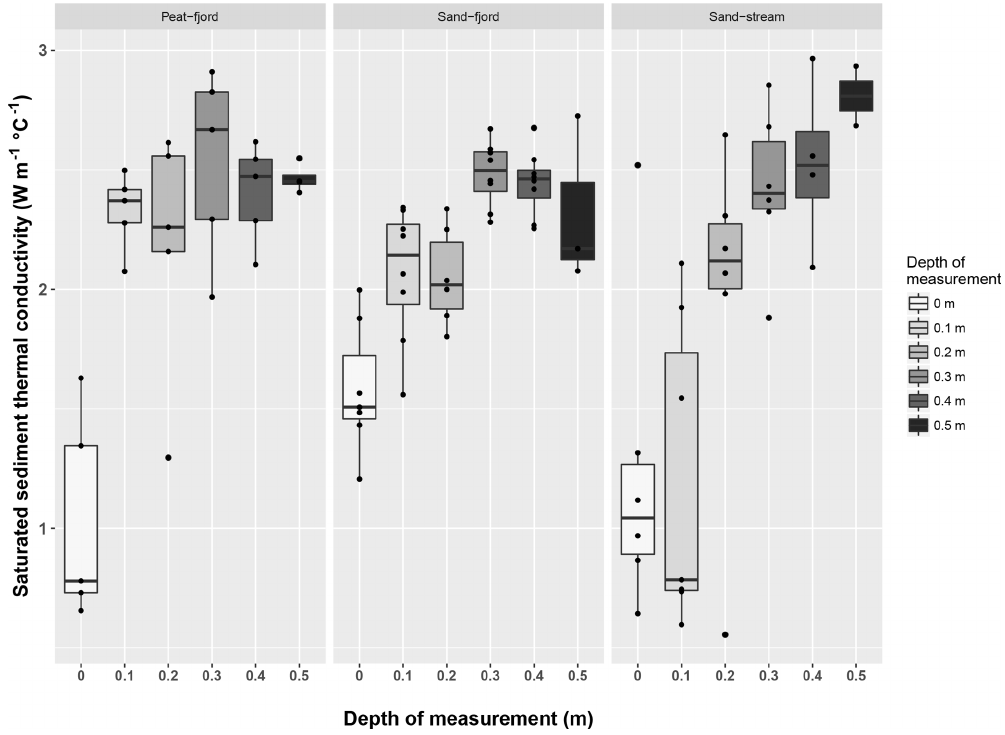
Figure 2. Box plot of measured sediment thermal conductivity values at each site over depth. Table 2. Summary of the average, minimum, maximum, and standard deviation of flux estimates at the two field sites using different distributions of measured sediment thermal conductivity in the individual profiles: a homogeneous distribution of standard literature values (Case 1), the average (Case 2), minimum (Case 3), and maximum (Case 4) measured values of the individual profiles, and a